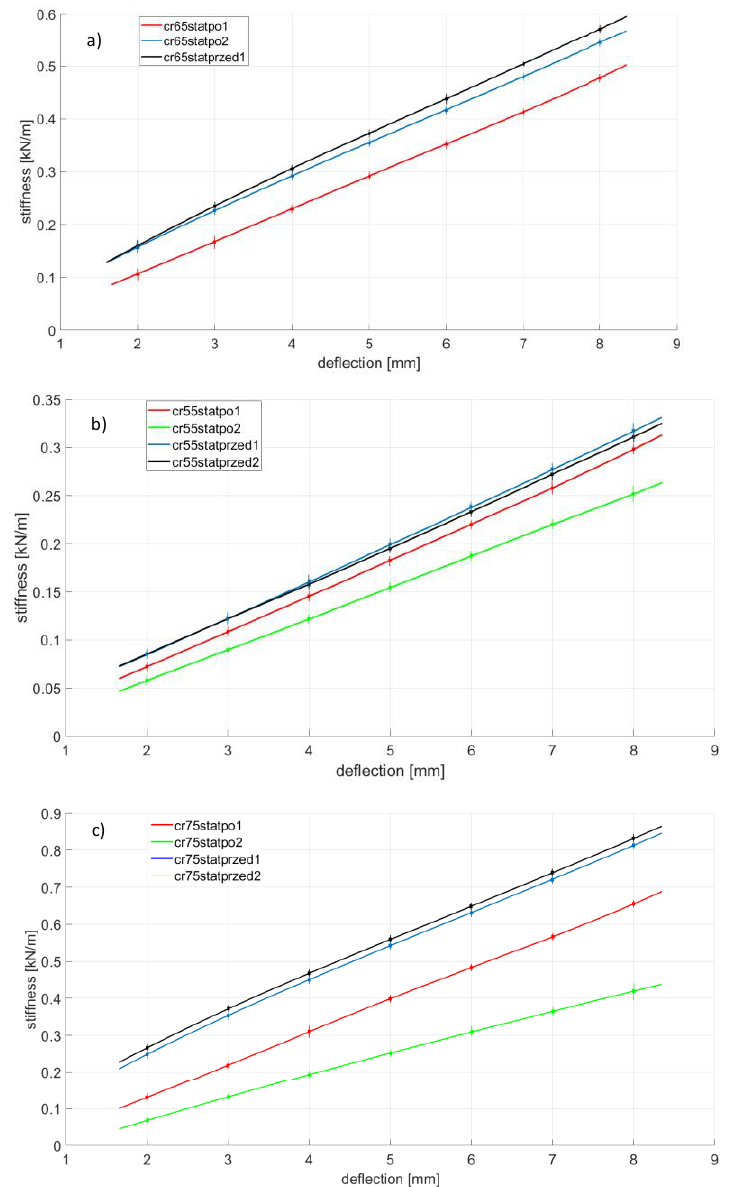
Figure 8. CR rubber changes of stiffness during various tests conducted on tensile machine, ( a )